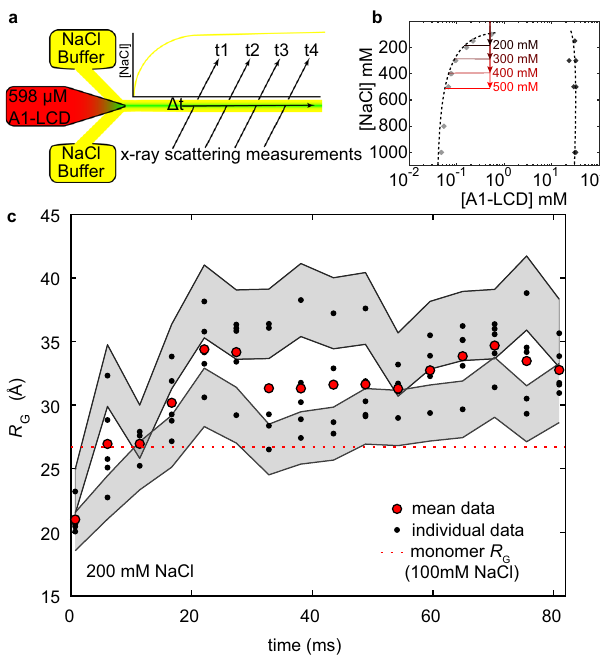
Fig. 5 Laminar- fl ow time-resolved SAXS experiments. a A schematic showing the laminar- fl ow experiment. A protein sample without excess salt (red) is focused into a thin stream, and ions from a sheath of buffer (yellow) rapidly diffuse into the solution, resulting in a sample of protein in a NaCl-containing solution (green). Scattering data is recorded as a function of position from mixing; data collection begins after the initial fast mixing phase. Data from successive time points are uncorrelated because the scan rate of teh X-ray beam is slower than the fl ow rate of the protein stream. The dead time is de fi ned by the period required for a threshold of 50% mixing to occur. b The quench depth of individual laminar- fl ow TR- SAXS experiments depicted on the A1-LCD binodal (from Fig. 2b). c R G values as a function of time after mixing for a sample mixed into 200 mM NaCl. All individual measurements are shown as black dots. Red circles are the average of all measurements at a particular time after mixing, i.e., position on the mixer. The uncertainty bounds represent the standard deviation in determining the R G from Guinier analysis 78 . The standard deviation is similar for each data point, and thus, gray shaded regions are centered only on the maximum and minimum R G values at each time point for clarity. the maximal experimentally measurable dimension and the assemblies manifest as a power-law decay at small angles in the SAXS curve (Supplementary Note 2). A large ensemble of molecules is measured at each time point, and individual molecules, or clusters of molecules, are only observed for a fraction of the integration time. Therefore, we cannot observe subcritical clusters growing and reaching critical size in the SAXS experiment. Instead, the data either reports on the distribution of subcritical clusters in the absence of nucleation or effectively counts the fraction of the system in mesoscopic assemblies in the presence of nucleation.